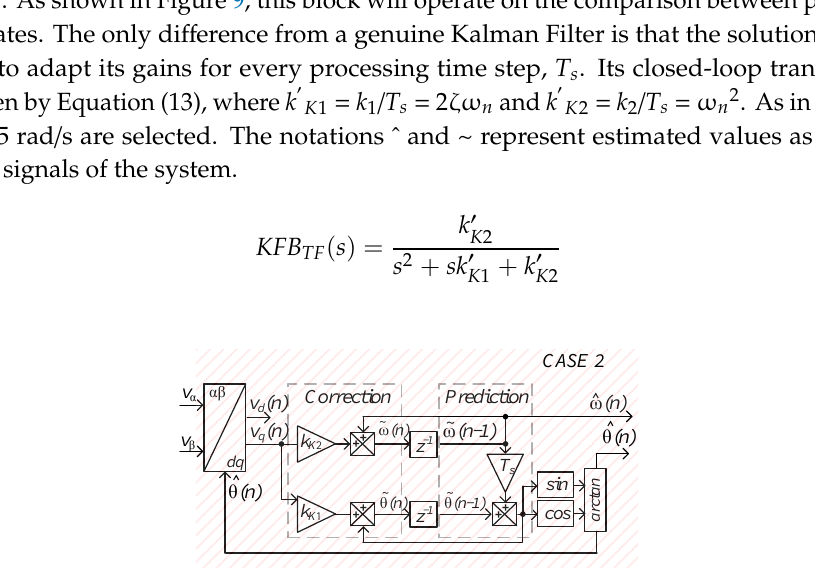
Figure 9. Second case for the frequency detection based on the orthogonal signals input and a Kalman Filter Based solution.